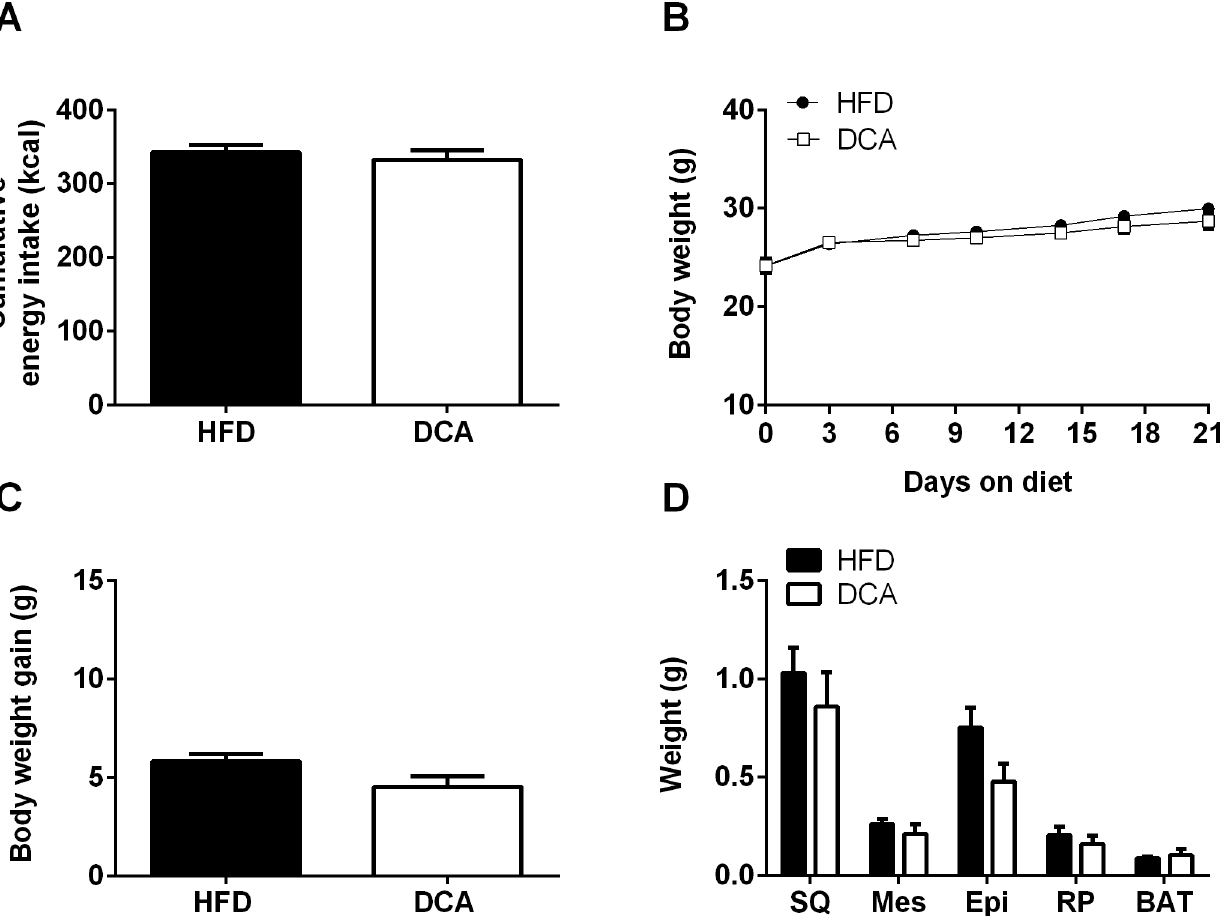
Fig 1. Food intake, body weight and adiposity. Energy intake (days 1–17, A), body weight (B), body weight gain (C) and adipose depot weights (subcutaneous (SQ), mesenteric (Mes), epididymal (Epi), retroperitoneal (RP) and brown adipose tissue (BAT)) (D). Data are expressed as mean ± SEM, n = 6 per